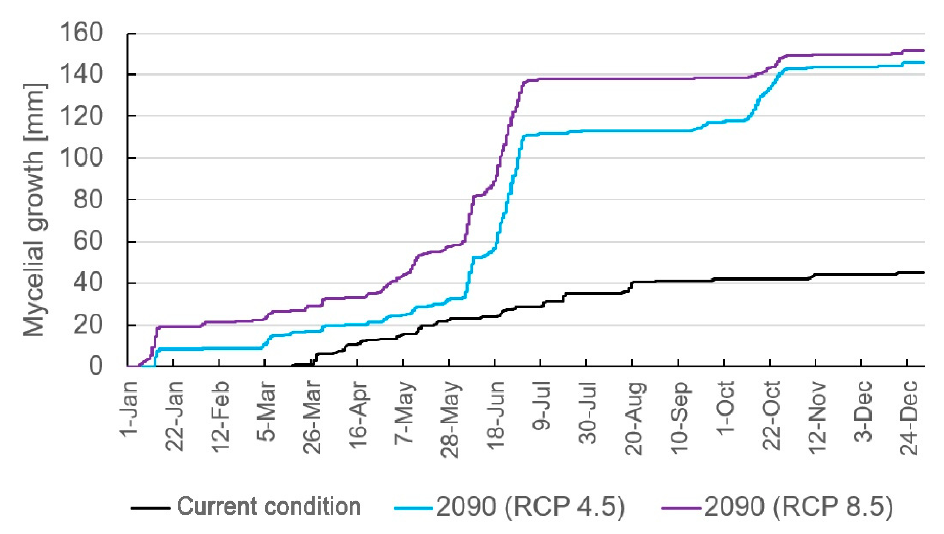
Figure 13. Mould growth for the different scenarios analysed.